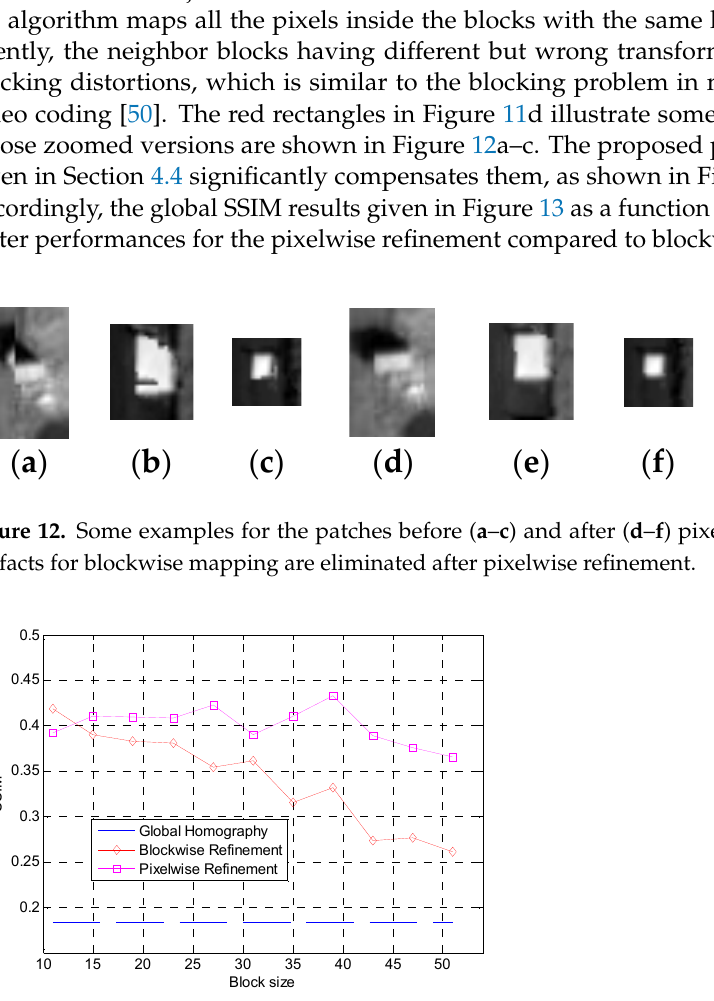
Figure 13. Global SSIM between transformed and reference images vs. block size for blockwise and pixelwise local refinements.